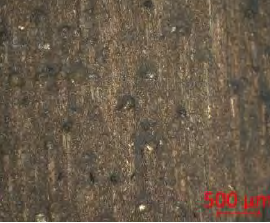
Fig . 4 . Grinding tool with grit size D151 .